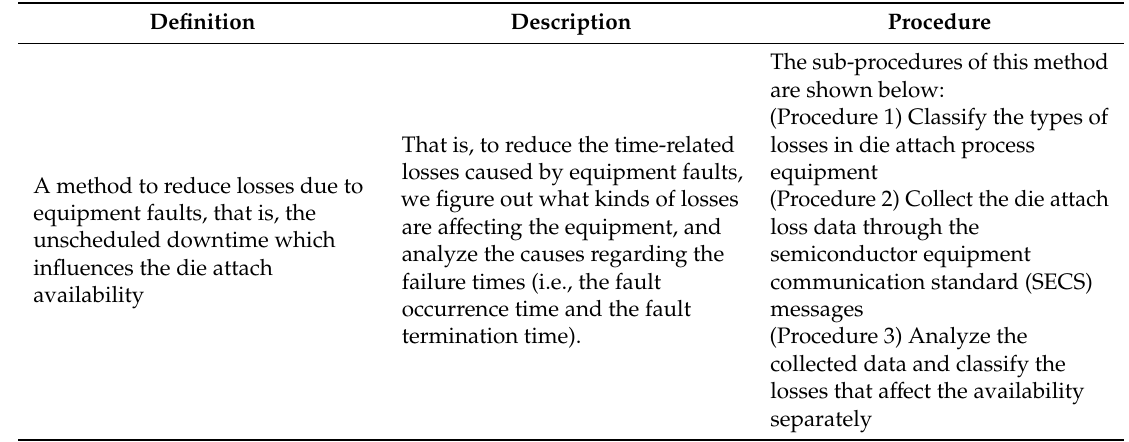
Table 3. Development method 1 of a new monitoring system.